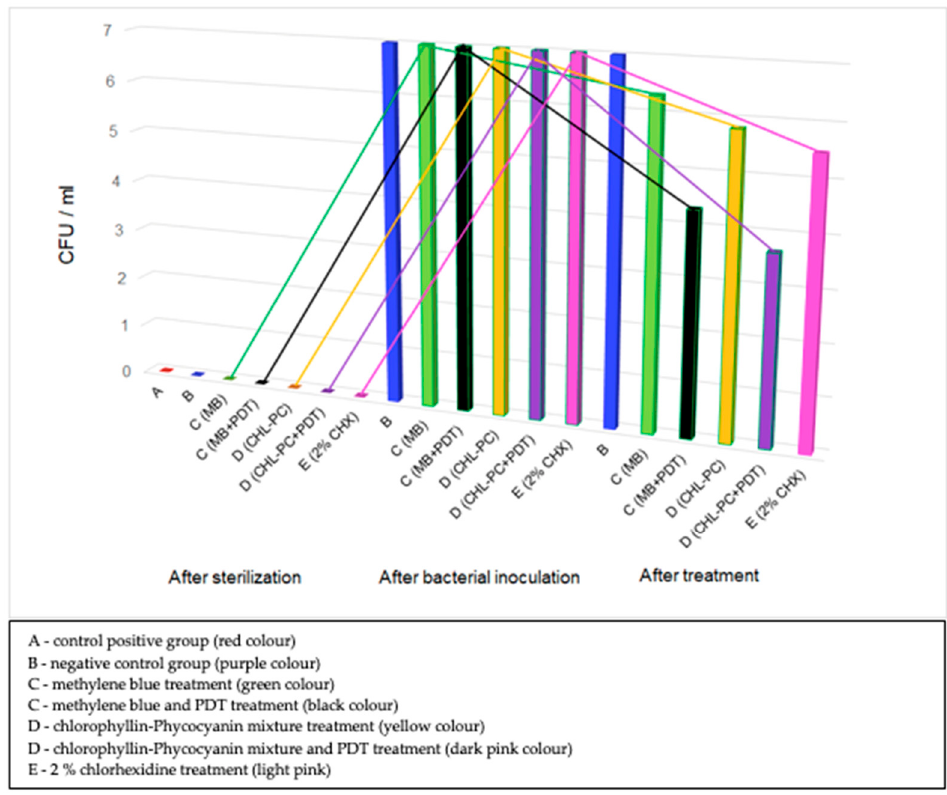
Figure 3. Evolution of the number of bacterial colonies at different stages of the interventional study.